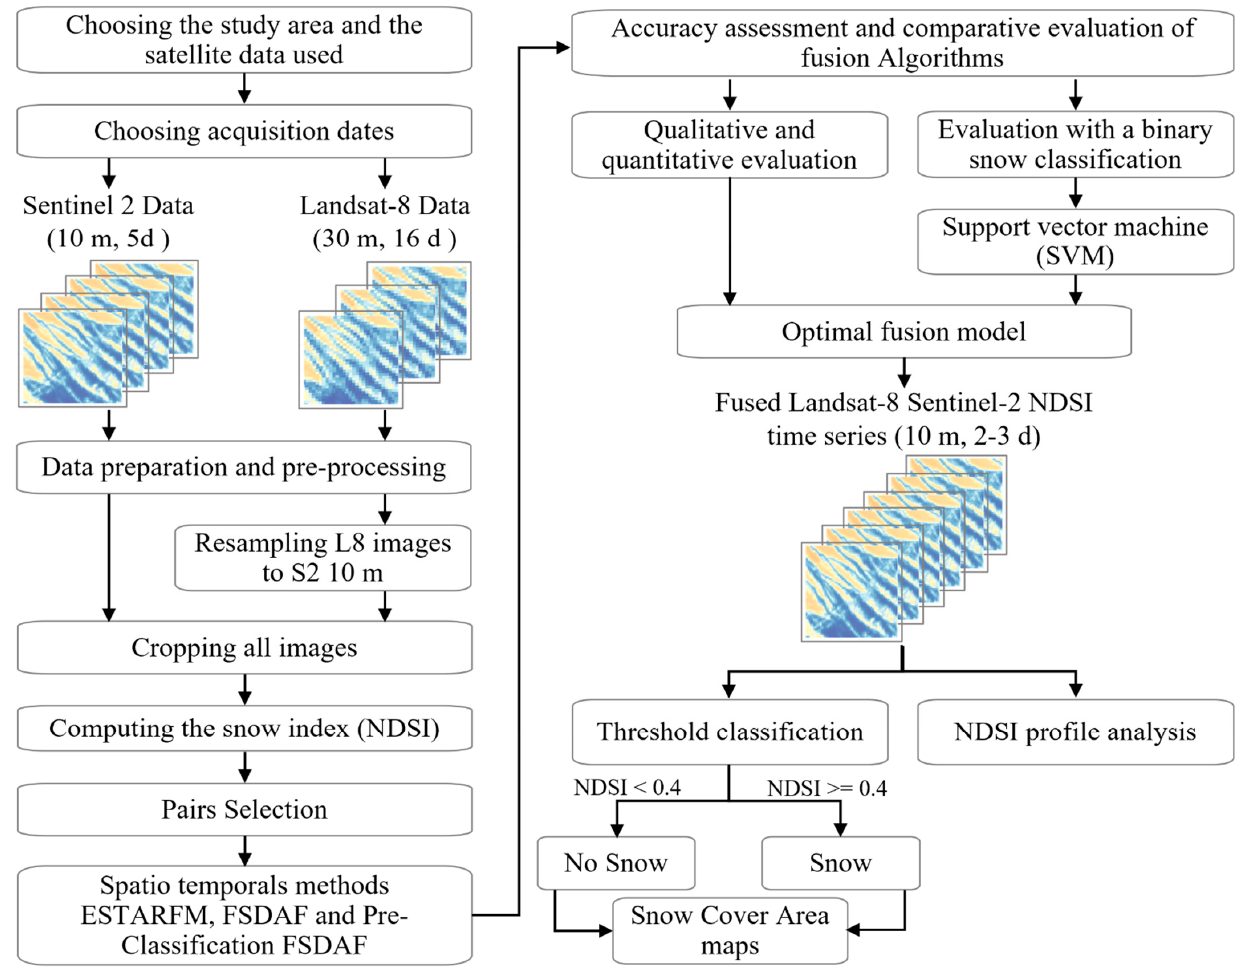
Figure 3. The general workflow employed in this